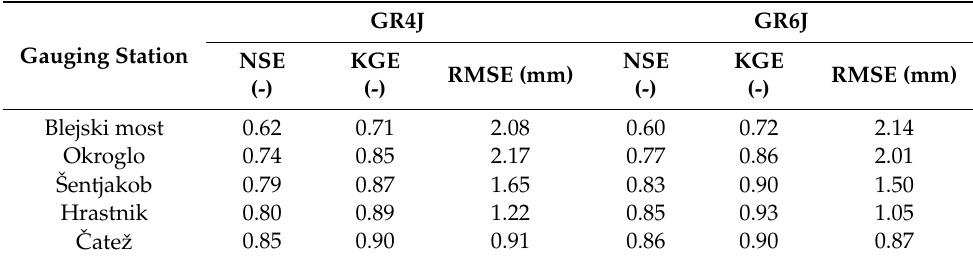
Table 2. Model efficiency criteria (i.e., Nash-Sutcliffe efficiency (NSE), Kling-Gupta efficiency (KGE), root mean square error (RMSE)) for the GR4J and GR6J models in the validation period for five considered catchments.